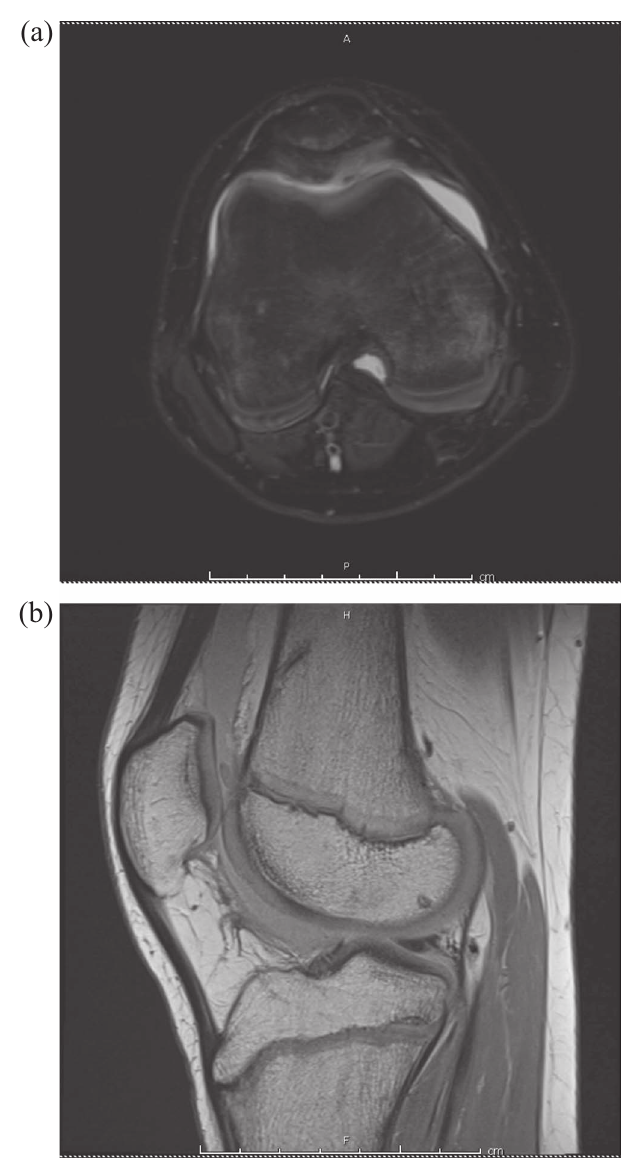
Figure 8. Axial T2- and sagittal proton density-weighted MRI showing incorporation of the previously fi xed chondral fragment with near anatomic articular surface (a and